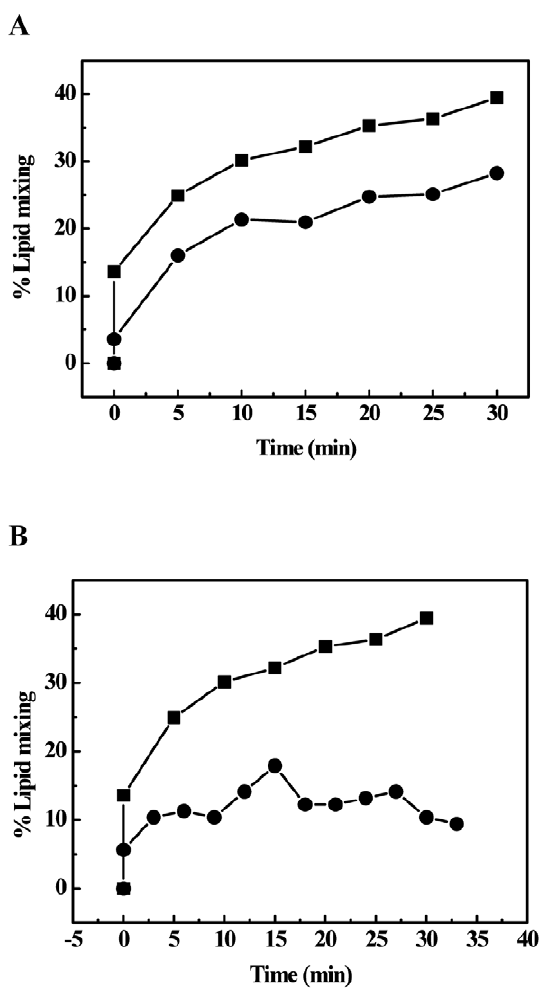
Figure 2. Peptide membrane interaction. (A) Living Vero cells were incubated with wtEBO 16 at 25 (circles) or 37 u C (square). Membrane mixing was followed by the decrease in the pyrene excimer/monomer fluorescence ratio for 30 min. (B) Living Vero cells in the absence (square) or in the presence (circle) of M b CD were incubated with wtEBO 16 at 37 u C. Membrane mixing was followed by the decrease in the pyrene excimer/monomer ratio for 30 min. The peptide concen- tration was 100 m M in all experiments. The M b CD concentration was 20 mM. The percentage of lipid mixing was obtained by the relation described in Freitas et al [12].